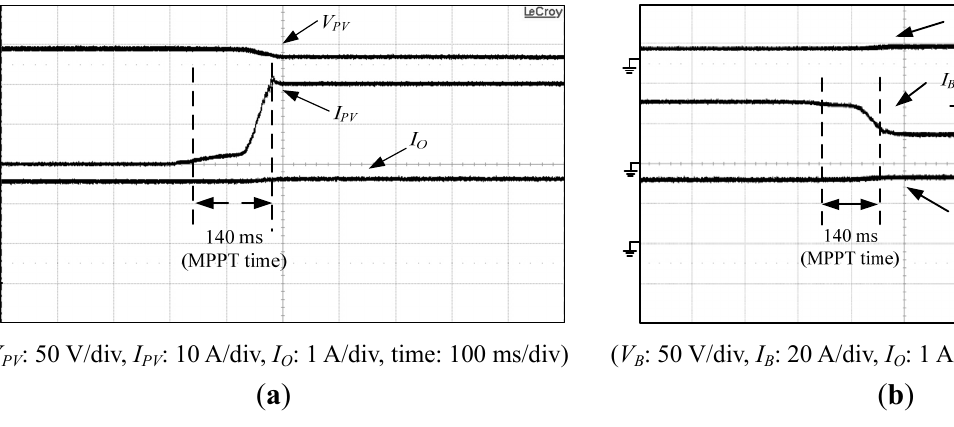
Figure 24. Measured voltage and currents waveforms of the proposed PV power system under output power P of 1 kW and PV arrays maximum power P O ( a ) P arrays voltage V , current I and output current I V PV PV , current I and output current I voltage V B B O